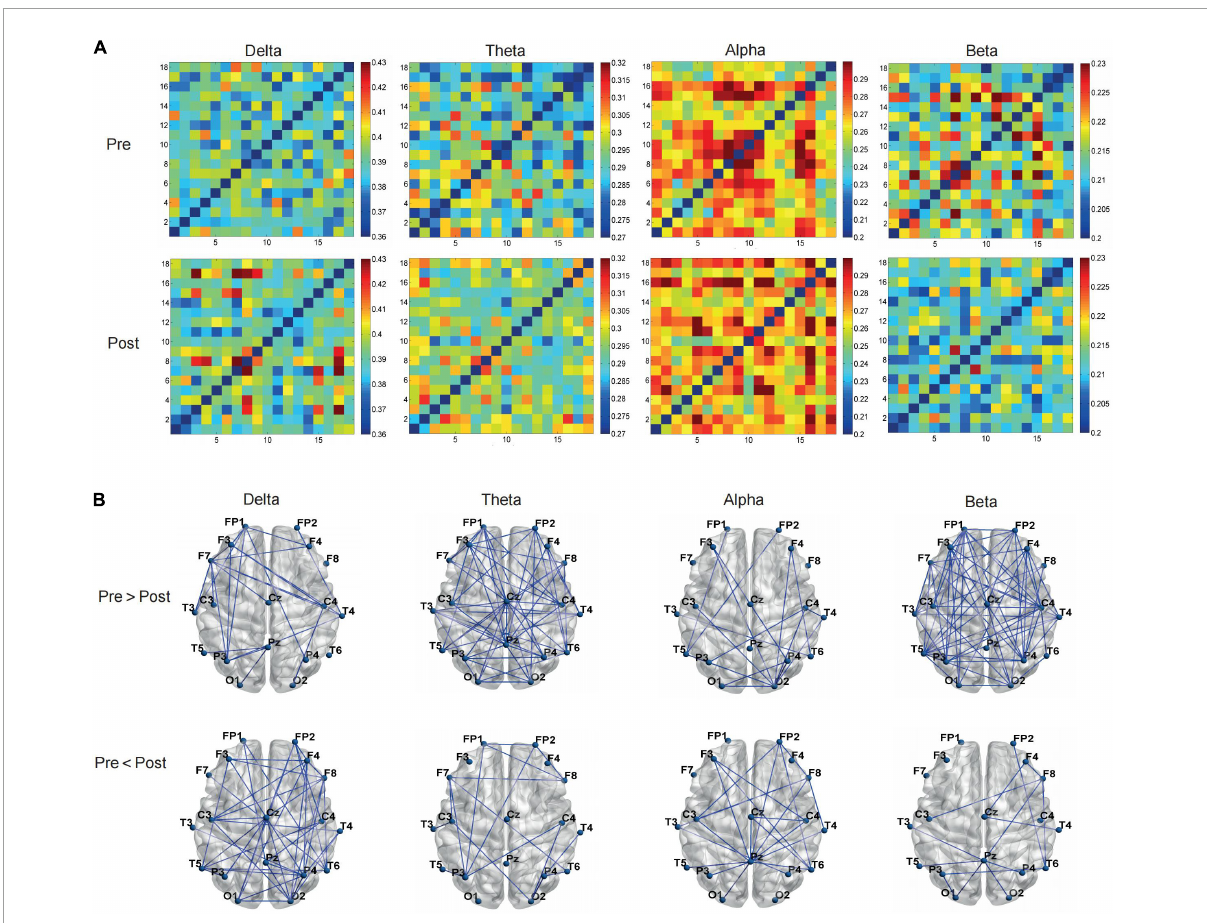
FIGURE6 The Qigong group (A) by regarding phase lag index (PLI) value as the strength, verified 18*18 PLI functional connection moments, calculated global, and local topological parameters (B) on the brain network from the graph theory.